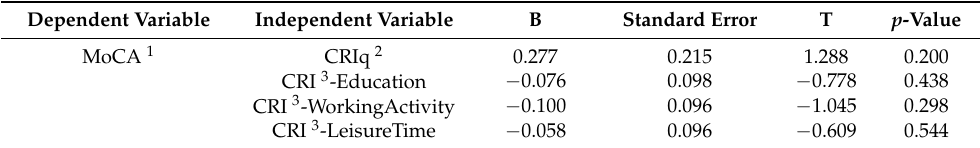
Table 6. Univariate regression analyses between CRIq and